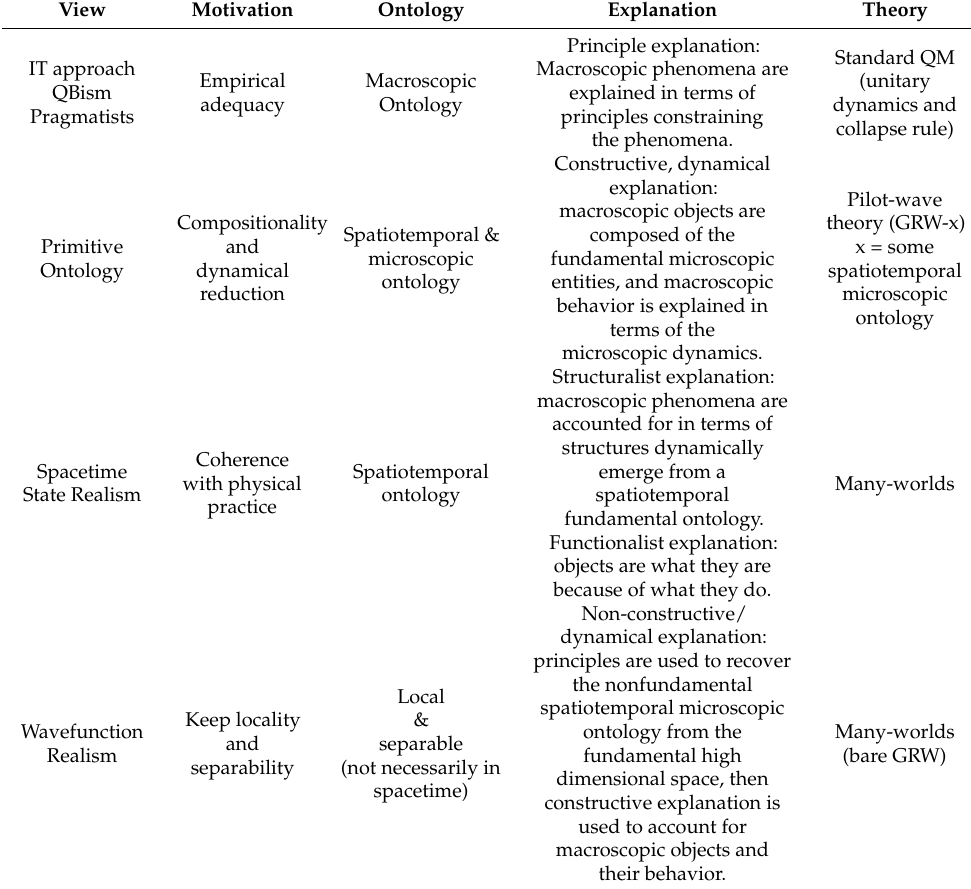
Table 1. Different views have different motivations and require different types of